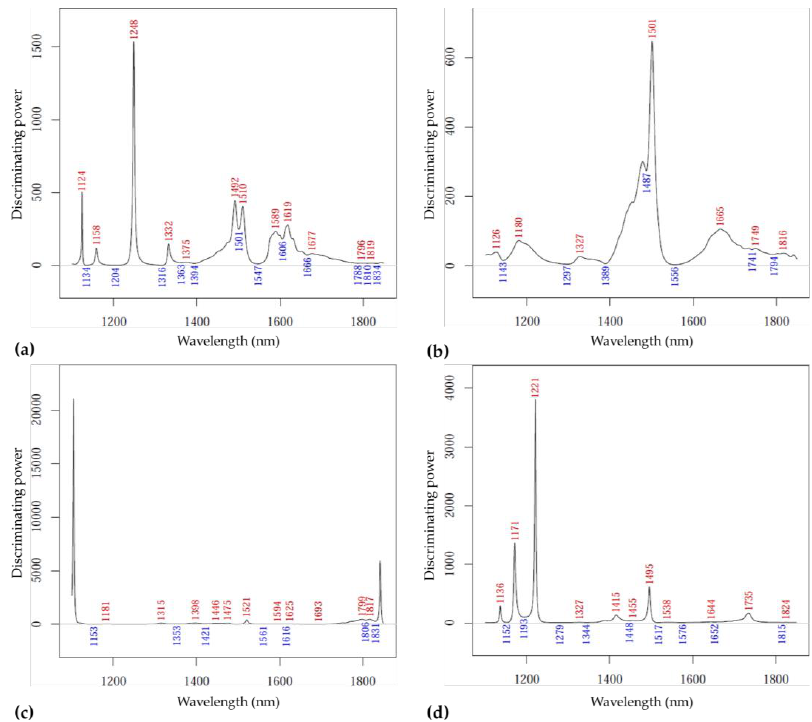
Figure 12. The SIMCA discriminating power plots for ripeness: ( a ) results of ‘Kántorjánosi’ samples on day 1 ( n = 28, k = 2); ( b ) results of ‘Újfehértói fürtös’ samples on day 1 ( n = 33, k = 1); ( c ) results of on day 1 ( n = 28, k = 2); ( b ) results of ‘ Ú jfeh é rt ó i fürtös’ samples on day 1 ( n = 33, k = 1); ( c ) results of ‘Kántorjánosi’ samples on day 10 ( n = 33, k = 2); ( d ) results of ‘Újfehértói fürtös’ samples on day 10 ( n = 33, k = 2). ‘K á ntorj á nosi’ samples on day 10 ( n = 33, k = 2); ( d ) results of ‘ Ú jfeh é rt ó i fürtös’ samples on day 10 ( n = 33, k =